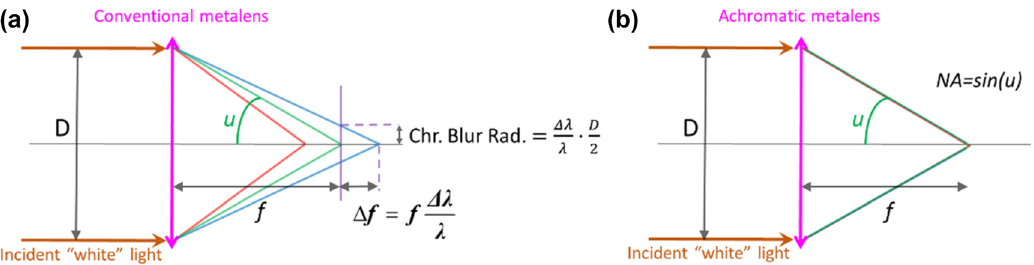
Figure 1: Sketch showing ray paths, basic parameters (lens diameter D, focal length f , and numerical aperture NA) and chromatic aberration (longitudinal chromatic aberration Δ f , and chromatic blur radius) for (a) conventional versus, (b) achromatic, diffractive lens.